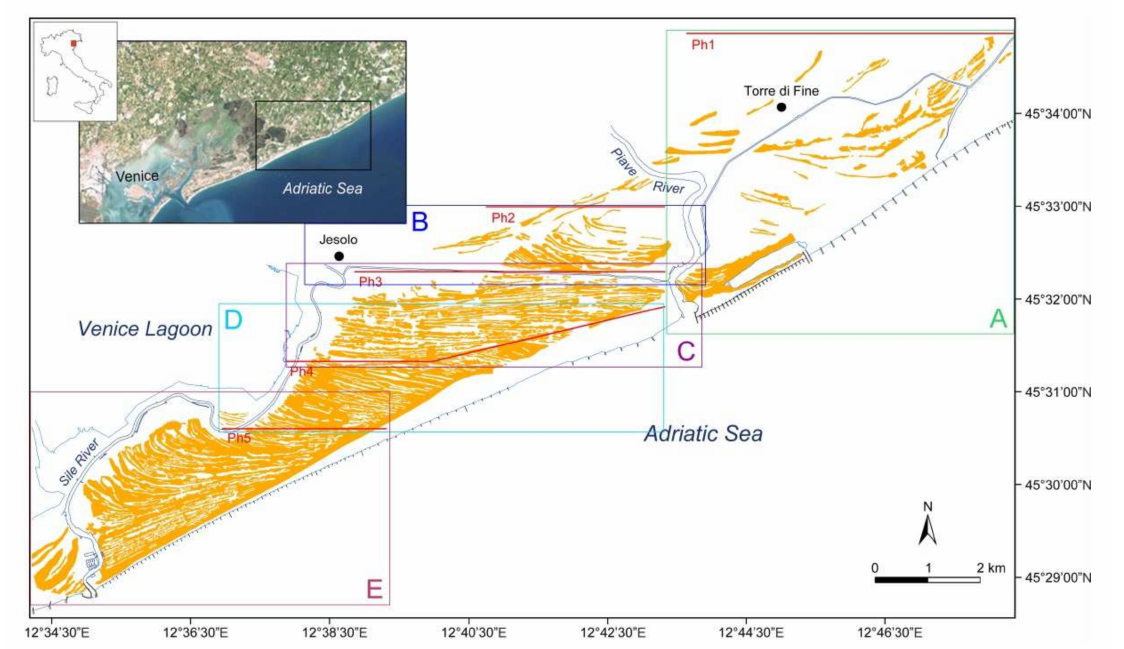
Figure 1. Location of the study area and arrangement of the ancient sandy ridges (orange strips) recognized in aerial photographs. The main progradation phases (Ph1 to Ph5) are separated by red lines. Rectangles A, B, C, D, and E indicate the locations of Figures 2–6.